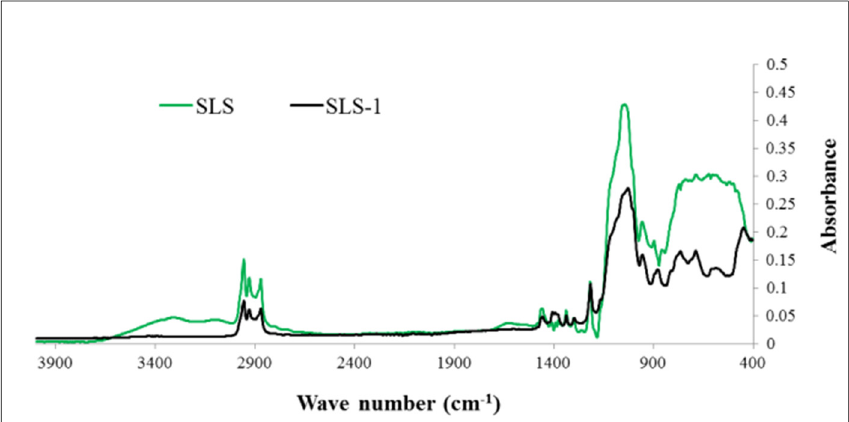
Figure 3. FT-IR spectra of SLS and SLS-1: (2960–2872 cm − 1 ) ν C–H; (1463–1297 cm − 1 ) ω C–H; (1215 cm − 1 ) ν Si–CH 2 ; (1060 cm − 1 ) ν Si–O–Si.